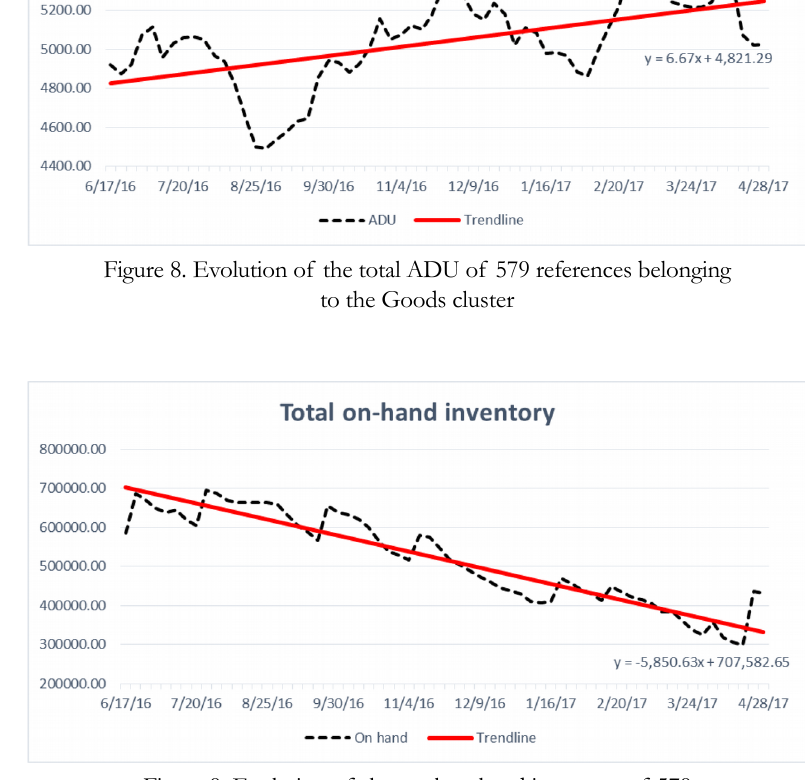
Figure 9. Evolution of the total on-hand inventory of 579 references belonging to the Goods cluster